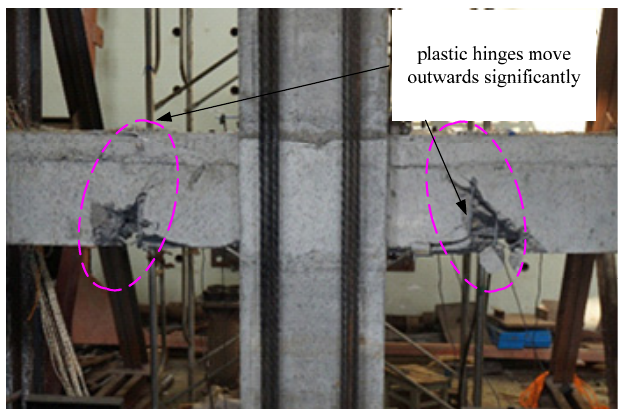
Figure 21. The plastic hinges moving outward on YZ2